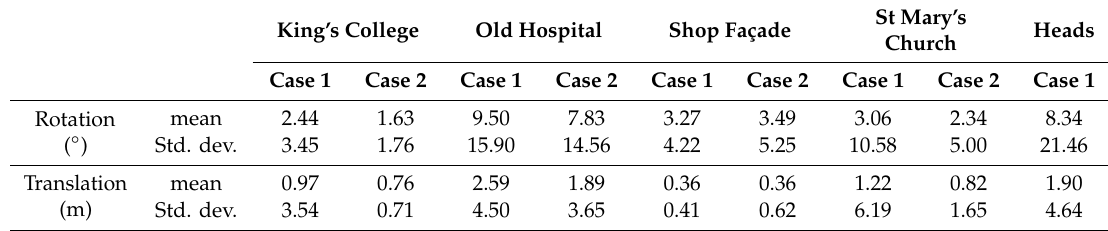
Table 5. Comparison of mean and standard deviation (std. dev.) of translation and rotation errors. King’s College